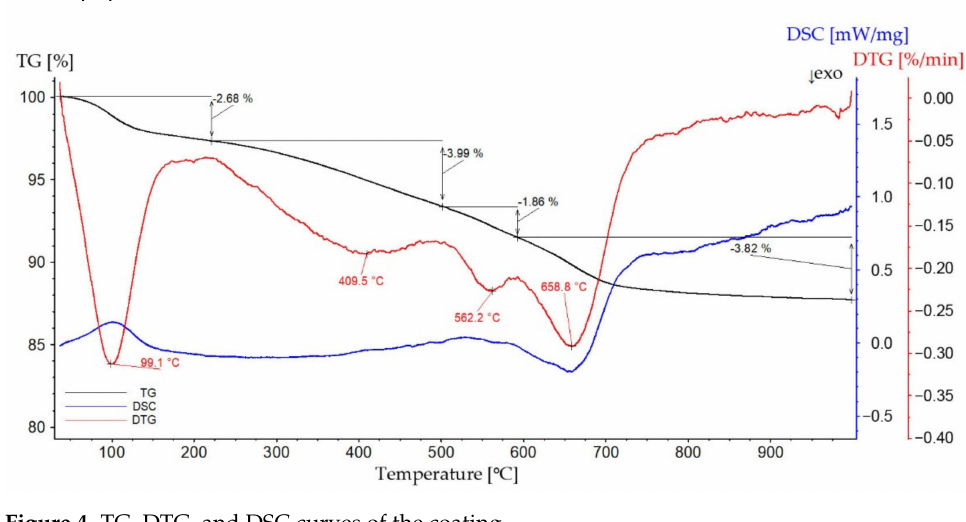
Figure 4. TG, DTG, and DSC curves of the coating.